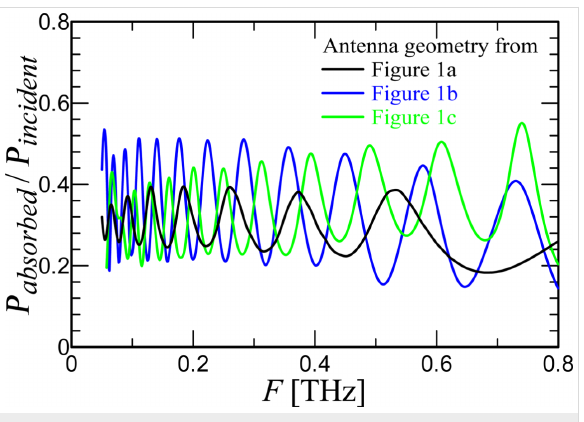
Figure 2: Normalized level of absorbed power in the port for the three antenna geometries in Figure